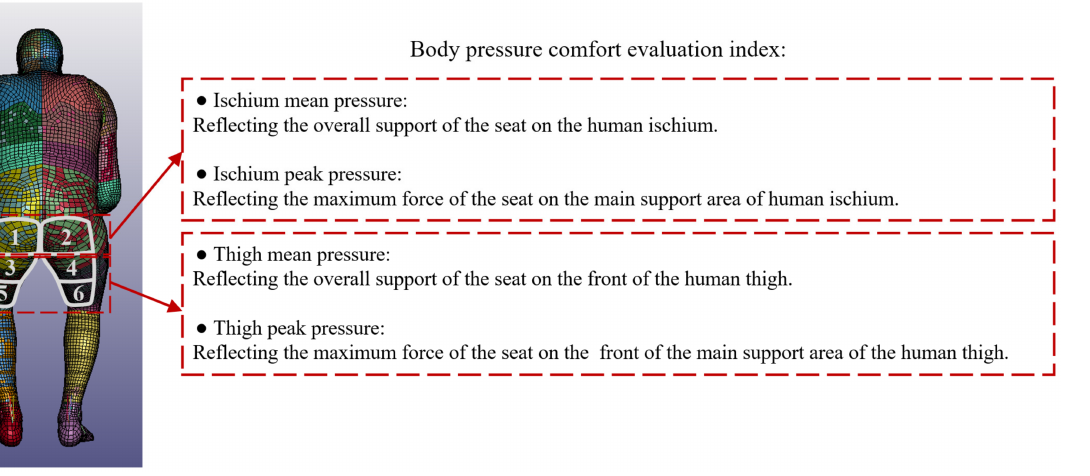
Figure 12. Human body area